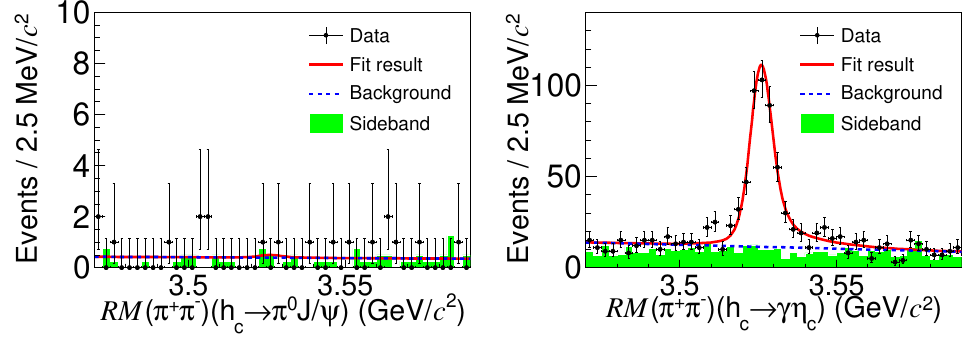
Figure 2 . Results of the simultaneous fit to the RM ( π + π − ) distributions from the decays h c → π 0 J/ψ (left panel) and h c → γη c (right panel). The red solid lines are the total fit results and the blue dashed lines are the background components. The green shaded histograms correspond to the normalized events from the J/ψ and η c sideband